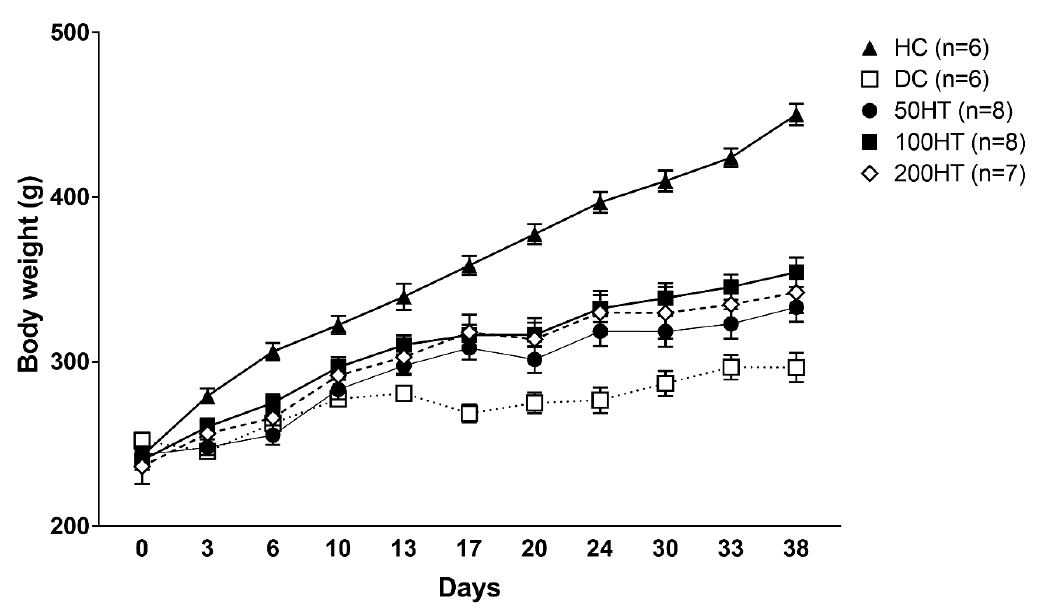
Figure 4. Effect of horsetail on body weight. For clearer representability the symbols showing statistically significant di ff erences are listed in Table 2. In Figure 4 and Table 2 the experimental groups names were abbreviated, as follows: healthy control (HC), diabetic control (DC), 50HT (animals treated with 50 mg / kg horsetail extract), 100HT (animals treated with 50 mg / kg horsetail extract) and 200HT (animals treated with 50 mg / kg horsetail